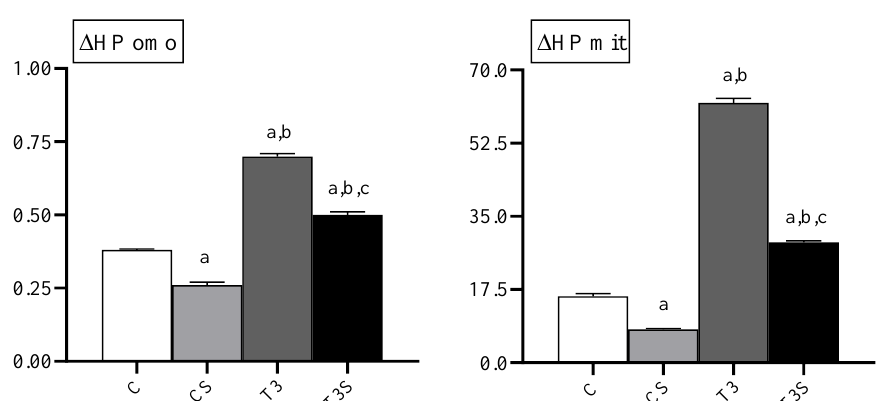
Figure 6. Susceptibility to oxidative stress in rat liver homogenates (omo) and mitochondria (mit) from C, control rats; CS, control rats fed with Chlorella sorokiniana ; T 3 , rats made hyperthyroid by ip. T 3 administration; and T 3 S, hyperthyroid rats fed with Chlorella sorokiniana. Susceptibility to oxidative stress was evaluated by changes in the HP levels (ΔHP) after Fe/As treatment. The values are means ± S.E.M of the data obtained on eight different livers. a significant vs. C, b significant vs. CS, and c significant vs. T 3 . The level of significance was chosen as p < 0.05.